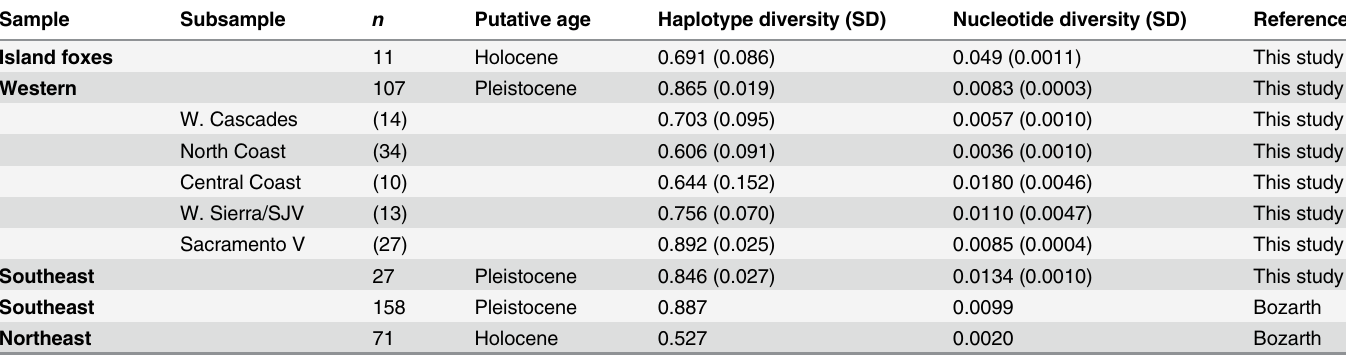
Table 4. Estimates of haplotype and nucleotide diversity in western gray foxes (mainland), island foxes, and eastern gray foxes from the present study, compared to those from Bozarth et al. (2011) for reference using 406 bp of D loop sequence common to both studies.